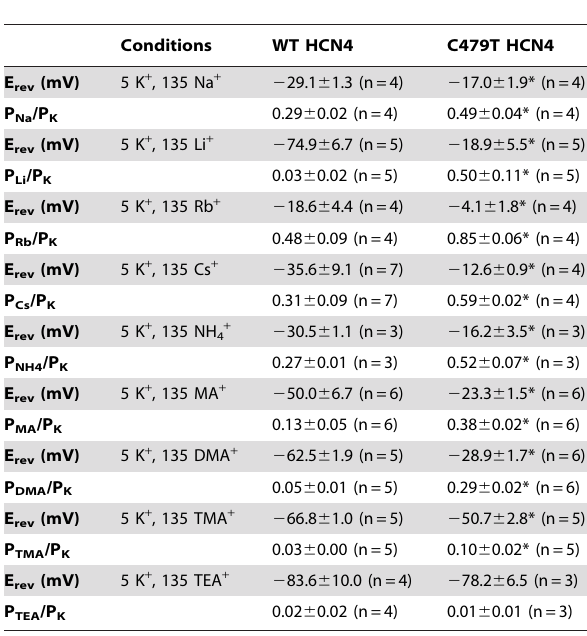
Table 1. E rev and P X /P K estimates in WT and C479T HCN4 channels.